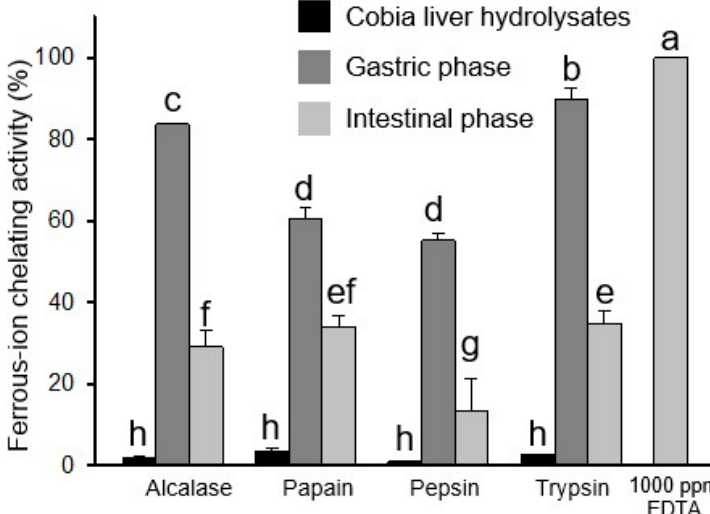
Figure 6. Effect of simulated gastro-intestinal digestion in vitro on ferrous-ion chelating activity of cobia liver hydrolysates obtained from AE by alcalase, papain, pepsin, and trypsin treatment. 1000 ppm EDTA was used as a positive control. Means with different superscript letters significantly differ ( p < 0.05).